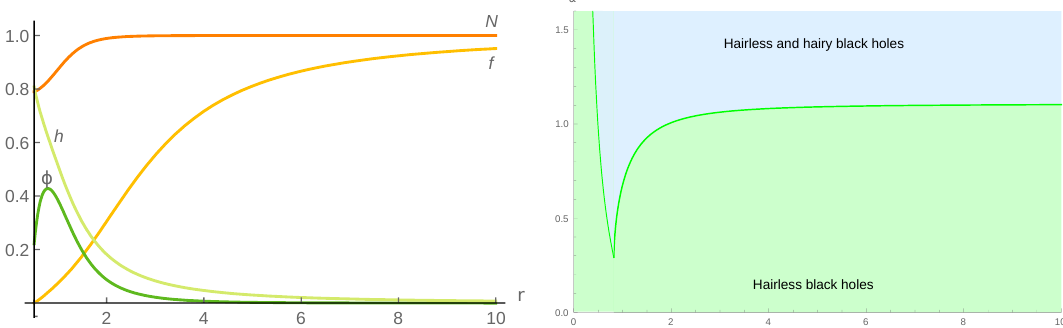
Figure 1 . Left: typical profiles for the functions N , f , h and φ on a hairy black hole solution, corresponding to q = 1 , m = 1 , α = 2 , h Right: regions with and without hairy black hole solutions in the q vs. α plane. For the sake of numerics we set m 2 = 1 and r